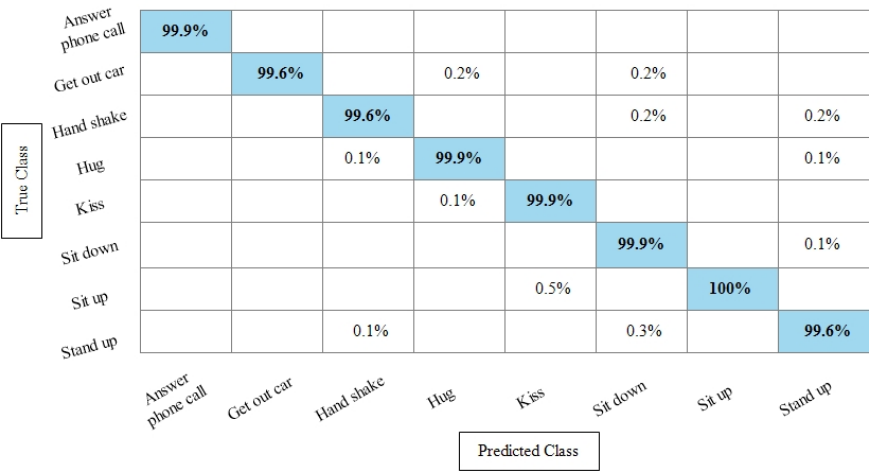
Figure 13. TPR based confusion matrix of Fine KNN after best feature selection using KcWKNN.